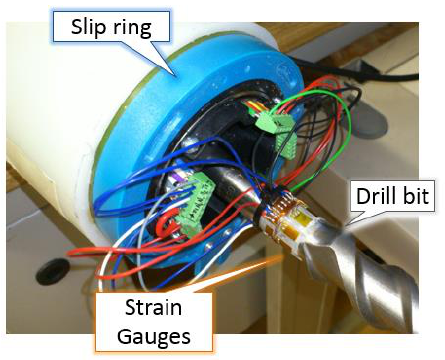
Figure 1. Strain gauges mounting on the drill bit and cables connected to the slip ring system.